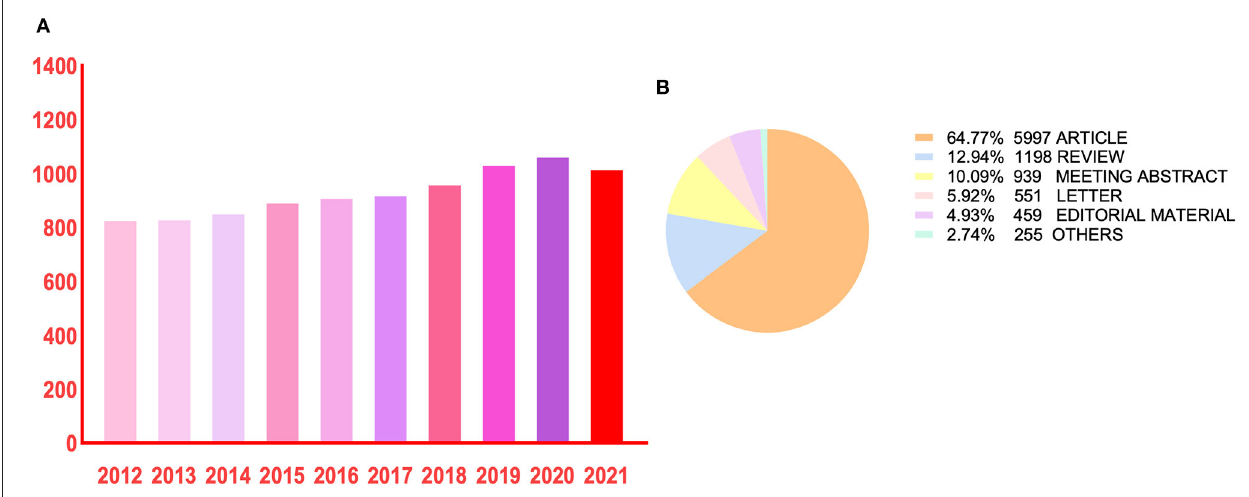
FIGURE 1 | Bibliometric analysis of publication outputs. 9,259 publications were included from 2012 to 2021. (A) The number of annual publications on herpes zoster. (B) The distribution of article type.